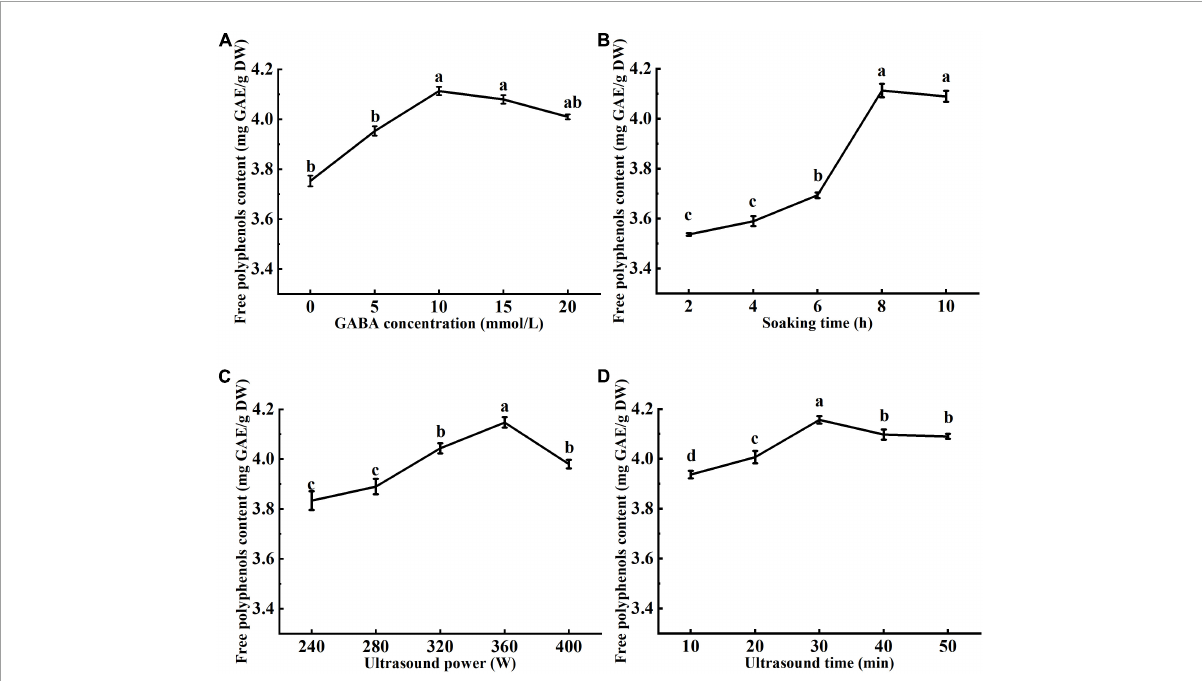
FIGURE1 Effects of γ -aminobutyric acid (GABA) concentration (A) , soaking time (B) , ultrasonic power (C) , and ultrasonic time (D) on the free polyphenol content of mung bean. The GABA concentration, soaking time, ultrasonic power, and ultrasonic time were 10 mmol/L, 8 h, 360 W, and 30 min, respectively. Data are mean ± SD ( n = 3). Different subscript letters indicate significant differences at p <